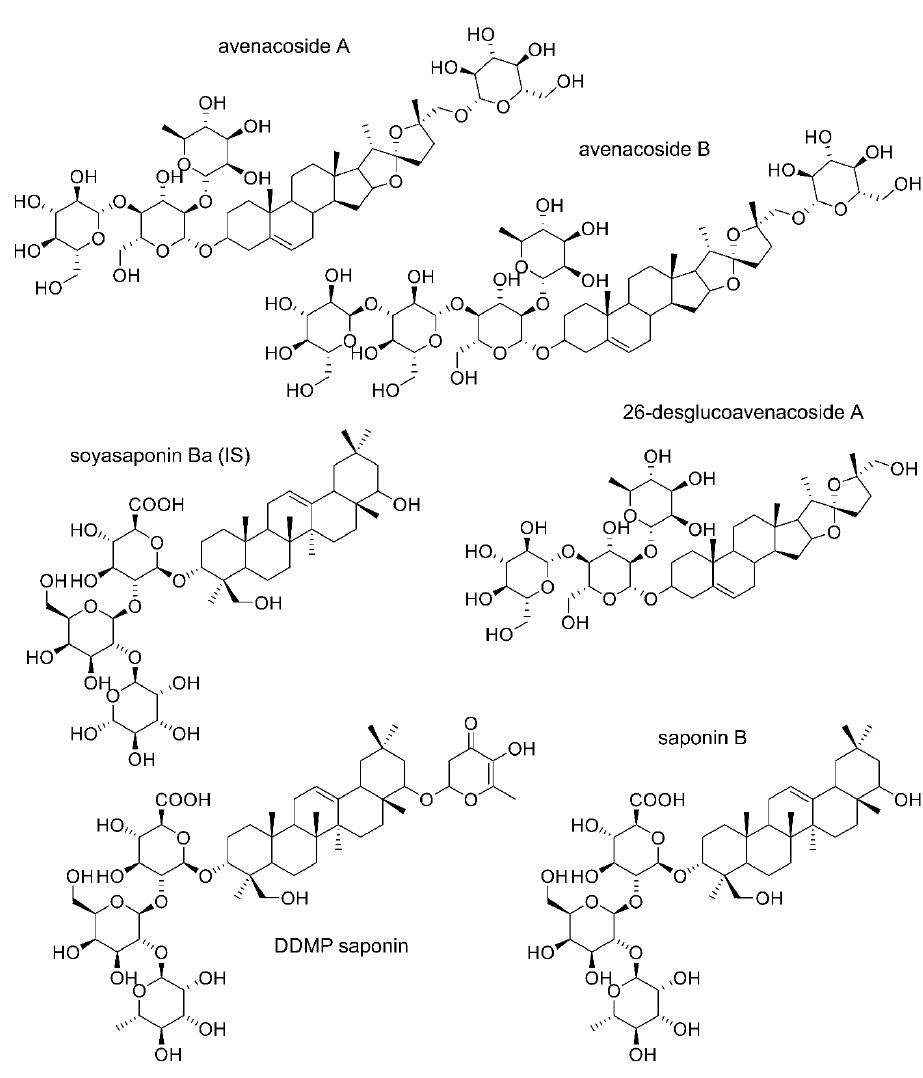
Figure 1. Chemical structures of saponins: avenacoside A, avenacoside B, and 26-desglucoavenacoside A from oat, saponin B and DDMP from pea, and soyasaponin Ba (used as internal standard [IS]).